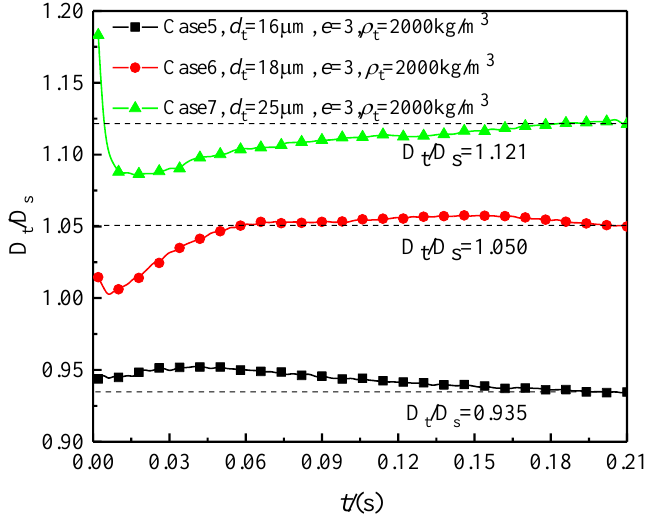
Figure 9. Variations of displacement ratio D t / D s between tracer and slurry particle with respect to time t under conditions of ρ t = 2000 kg/m 3 , e 0 = 3, d t / d s = 1.6, 1.8, and 2.5. Figure 10 summarizes the variations of the stable values of D t / D s with d t / d s for the two mass densities of the tracer, i.e., ρ t = 2650 kg/m 3 and 2000 kg/m 3 . It can be seen from the figure that the stable value of D t / D s increased with the mass density ratio ρ t / ρ s , which means the representativeness of the tracer decreased. Among the Cases 1~3 and 5~7 considered in Figure 10, the tracer of diameter 18 µ m and of mass density 2000 kg/m 3 , i.e., Case 6, provided the best representativeness on the displacement response of the slurry particles.